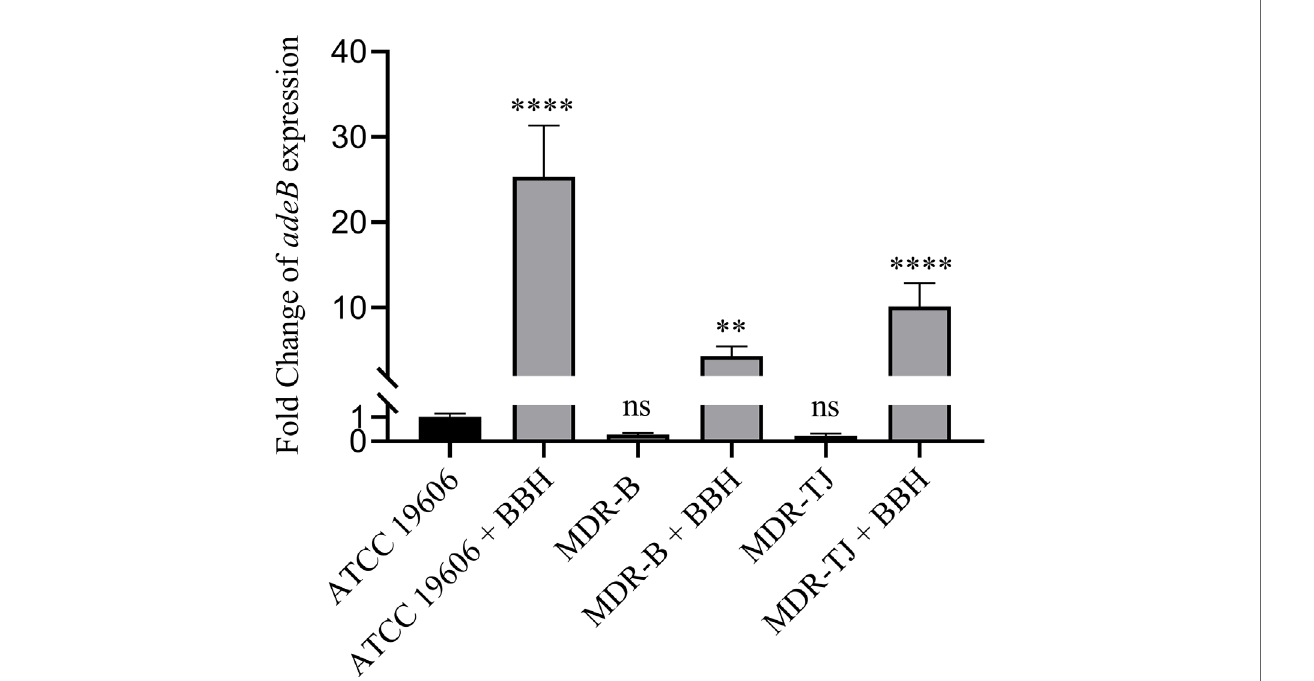
FIGURE 3 | Quanti fi cation of adeB expression normalized with A. baumannii ATCC 19606. BBH was added at half MIC corresponding to each stain, which is 128 mg/L for MDR-B and 512 mg/L for MDR-TJ and ATCC 19606, respectively. Statistical analysis was carried out using one-way analysis of variance (ANOVA) with Tukey ’ s test by GraphPad Prism 8. ns, no signi fi cance; **P < 0.01; ****P <